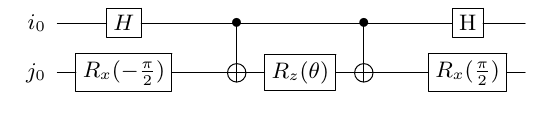
FIG. 3. A quantum circuit implementing the term ) exp ( − i θ X i Y j 2 0 0